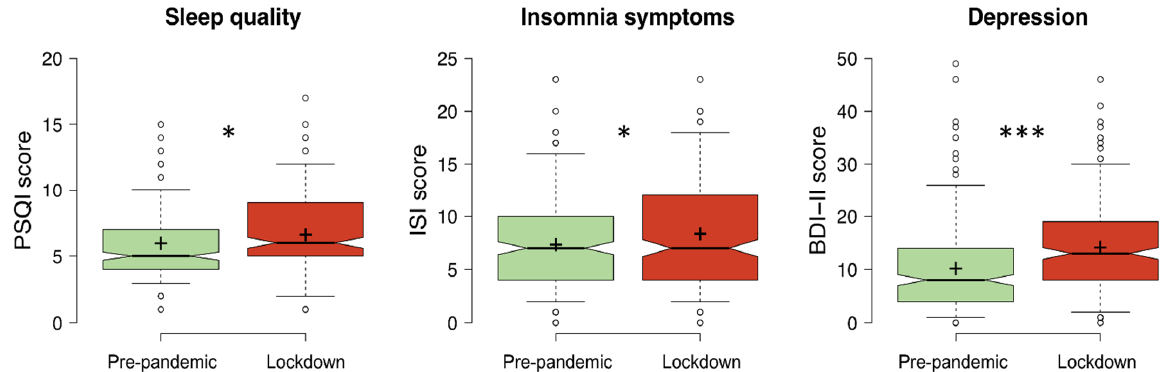
Figure 1. Sleep quality (PSQI), severity of insomnia (ISI), and depression symptoms (BDI-II) of the students in pre-pandemic group (assessed in 2016) and the group of students evaluated during the COVID-19 lockdown. Center lines show the medians; box limits indicate the 25th and 75th percentiles; whiskers extend to 5th and 95th percentiles, outliers are represented by dots; crosses represent sample means. Significant differences between groups of students (pre-pandemic, lockdown) are indicated with asterisks (* p < 0.05, *** p < 0.001). Abbreviations: PSQI, Pittsburgh Sleep Quality Index; ISI, Insomnia Severity Index; BDI-II, Beck Depression Inventory-Second Edition.